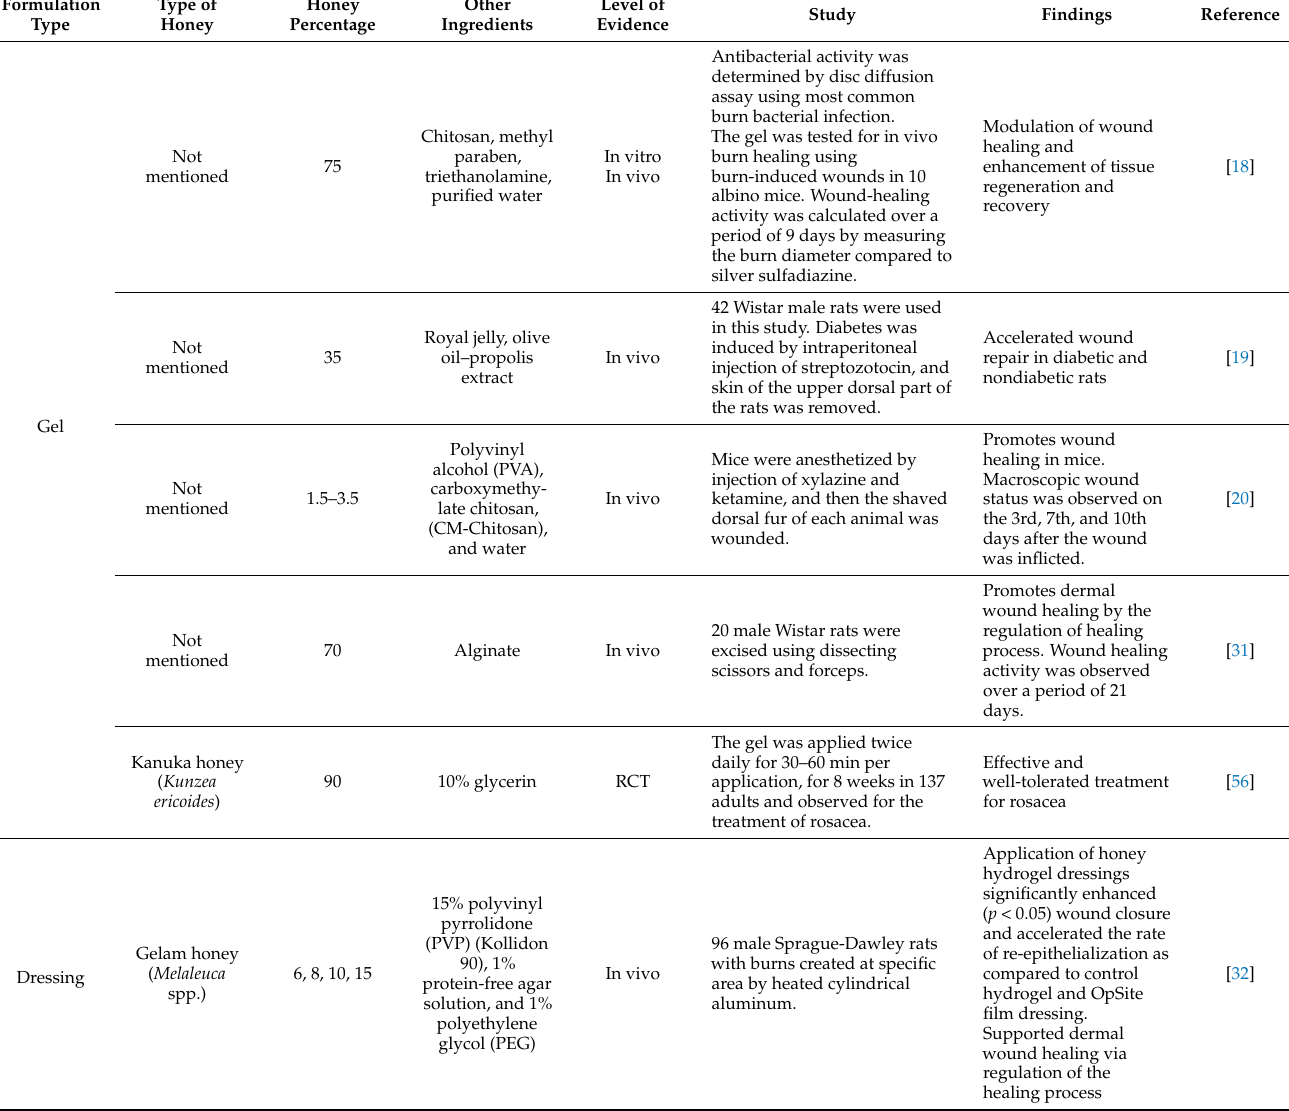
Table 2. Noncommercial honey-based